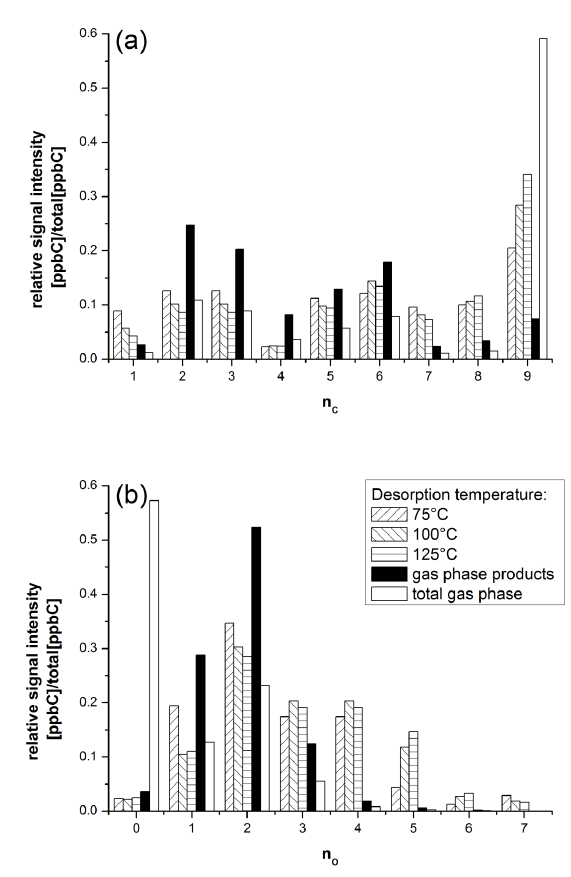
Fig. 8. Relative distribution of total carbon in thermally desorbed Figure 8. Relative distribution of total carbon in thermally desorbed SOA (75°C, 100°C, 3 SOA (75 ◦ C, 100 ◦ C, 125 ◦ C) and in the gas phase (products only 125°C) and in the gas phase (products only and total gas phase including TMB) according to 4 and total gas phase including TMB) according to the carbon atom the carbon atom number (a) and according to the oxygen atom number (b). SOA and gas 5 number (a) and according to the oxygen atom number (b) . SOA and phase samples were taken between 4.5 and 6 hours of reaction time (experiment 1b). 6 gas phase samples were taken between 4.5 and 6h of reaction time (experiment 1b).